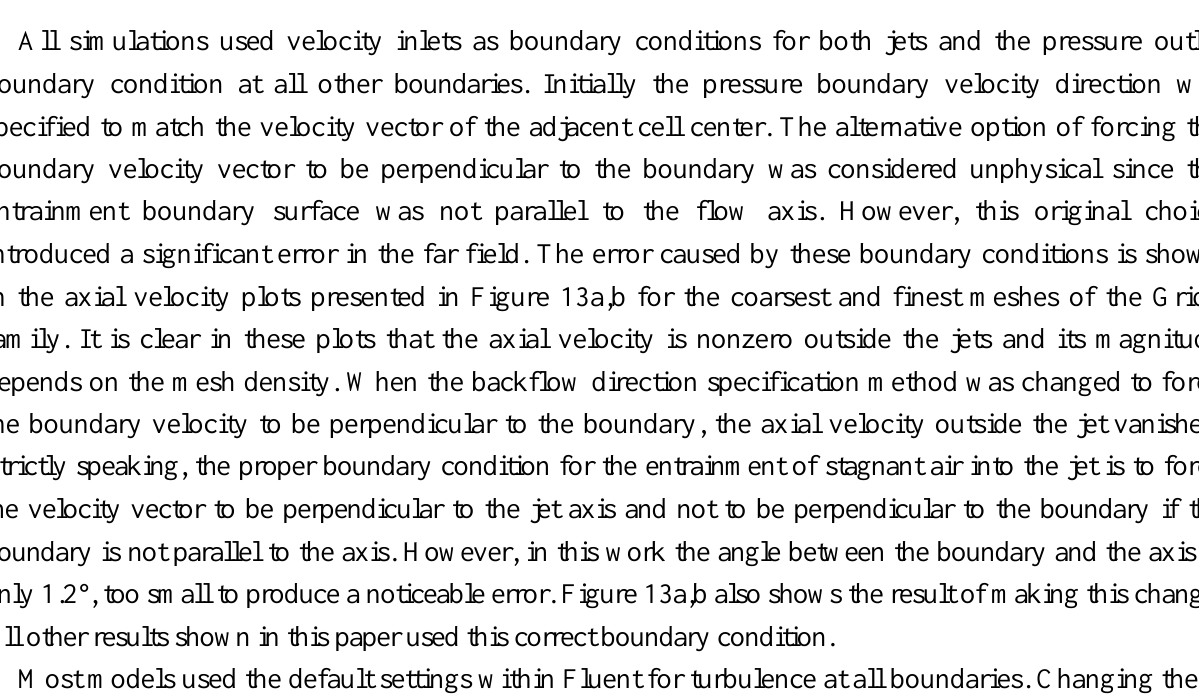
Figure 13. Experiment 1: ( a ) the effect of changing the circumferential boundary condition on the simulated flow field at 10 cm from the origin of the annular air jet (The